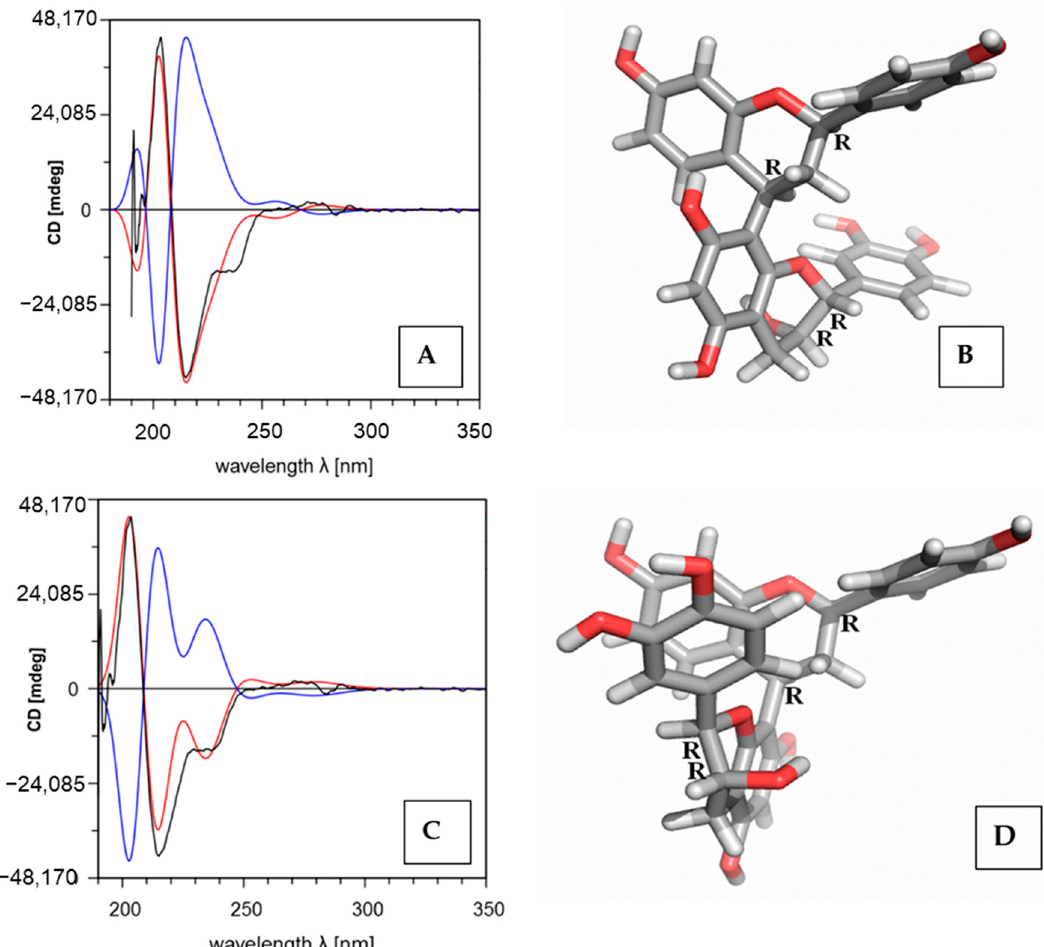
Figure 1. ( A ) Calculated ECD spectrum (red curve) for the most stable conformation of the C4–D8 RRRR P atropisomer with a high similarity of 0.9674 and a shift of 19 nm to the experimental ECD-spectrum (black curve); the spectrum of the C4–D8 SSSS M enantiomer is shown by the blue curve, which does not fit. ( B ) Related structure with the dihedral angle (A10–C4–D8–D9) = 135.9 ◦ . ( C ) Calculated ECD spectrum (red curve) for the C4–D8 RRRR M atropisomer with a relative energy of 1.7 kcal/mol and a high similarity of 0.9642, but a high shift of 30 nm to the experimental ECD spectrum (black curve); the spectrum of the C4–D8 SSSS P enantiomer is shown by the blue curve, which does not fit. ( D ) Related structure with the dihedral angle (A10–C4–D8–D9) = − 60.6 ◦ . Combining the Boltzmann weighted spectra of the most stable structures ( RRRR P and RRRR M atropisomer) gives a ratio of P/M = 19:1 and a slightly increased similarity of 0.9682. However, the superimposed spectrum looks almost identical to that shown in Figure 1A.